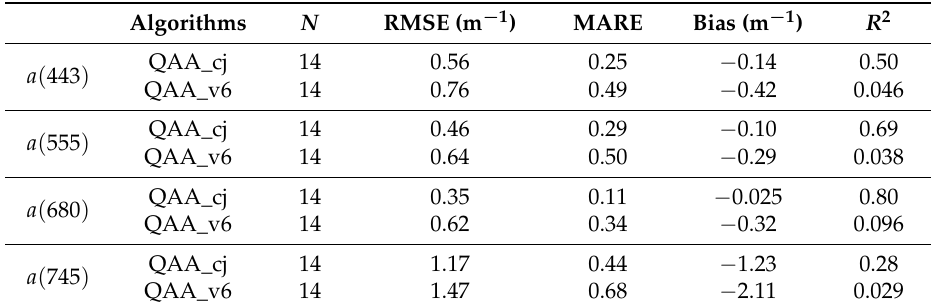
Table 6. Comparison statistics of QAA_cj and QAA_v6 based on in situ dataset and GOCI-derived at